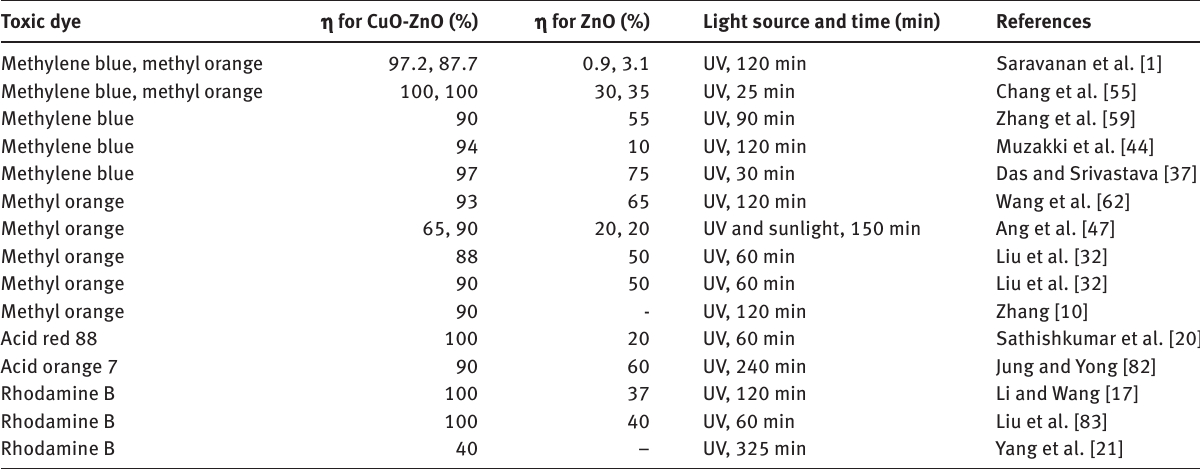
Table 1: Photocatalytic application of CuO-ZnO nanocomposite for different toxic dyes. Toxic dye η for CuO-ZnO (%) η for ZnO (%) Light source and time